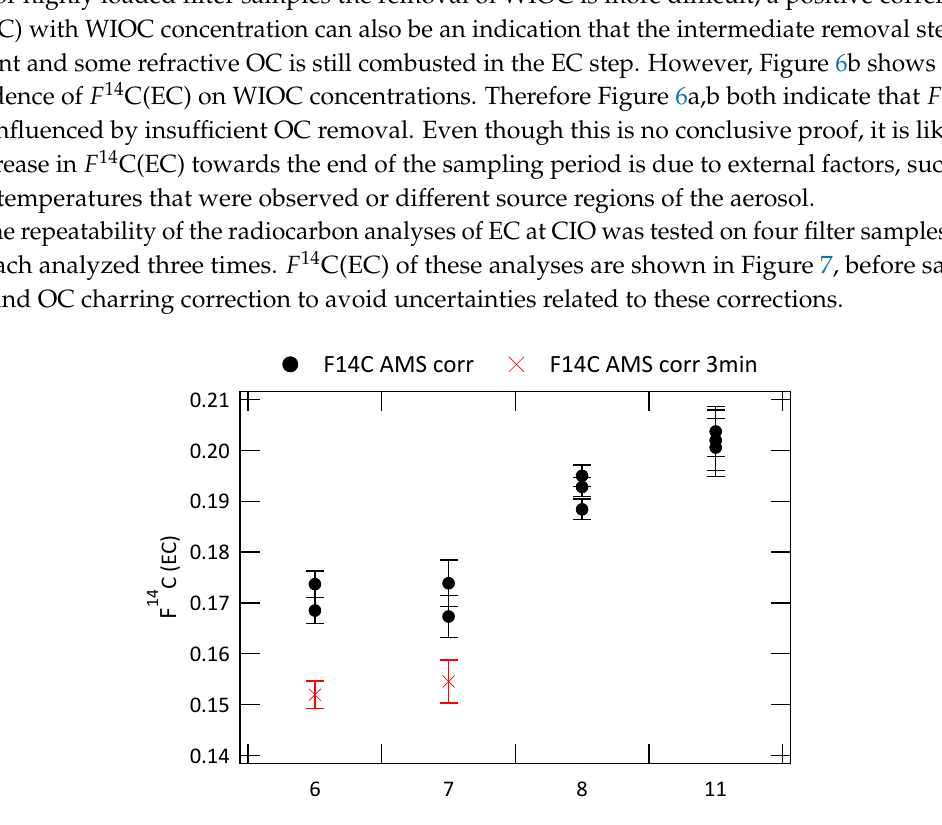
Figure 7. F 14 C(EC) analyzed multiple times for four different filter samples with a 2min intermediate step (F14C AMS corr). Two filters are additionally analyzed with an intermediate temperature step of 3min (F14C AMS corr 3min). No sampling blank and OC charring correction is